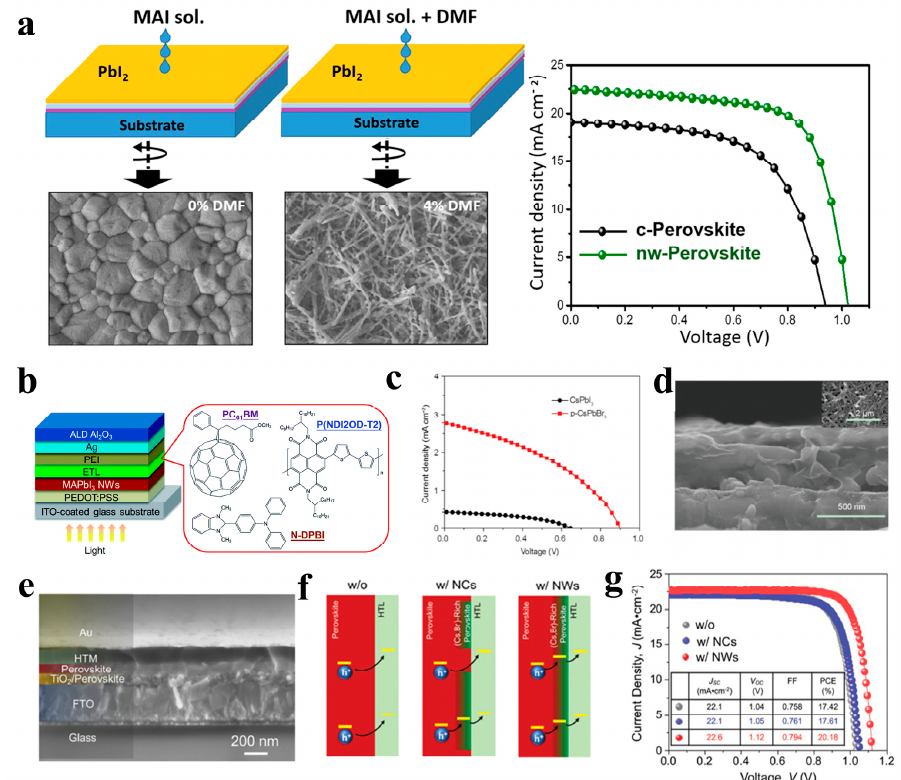
Figure 14. ( a ) Schematic diagram of the two‑step preparation and corresponding SEM image of the compact perovskite (c‑perovskite) and NW‑perovskite (left). J − V curves of the PSC devices (right). Reproduced with permission from reference [110]. Copyright 2018, Elsevier. ( b ) Schematic illustration of the device architecture and the molecular structures of ETL materials. Reproduced with permission from reference [112]. Copyright 2017, Royal Society of Chemistry. ( c ) J − V characteristics and ( d ) SEM images of the PSCs based on CsPbBr 3 NWs. Reproduced with permission from reference [113]. Copyright 2017, Springer Nature. ( e ) Cross‑sectional SEM image of the device based on CsPbBr 3 NW‑incorporated MAPbI 3 thin film. ( f ) Schematic illustration of the hole‑extraction in the devices without CsPbBr 3 NCs (left), with CsPbBr 3 NCs (middle), and with CsPbBr 3 NWs (right) incorporation. ( g ) J − V curves of the devices. Reproduced with permission from reference [114]. Copyright 2019, John Wiley and Sons.